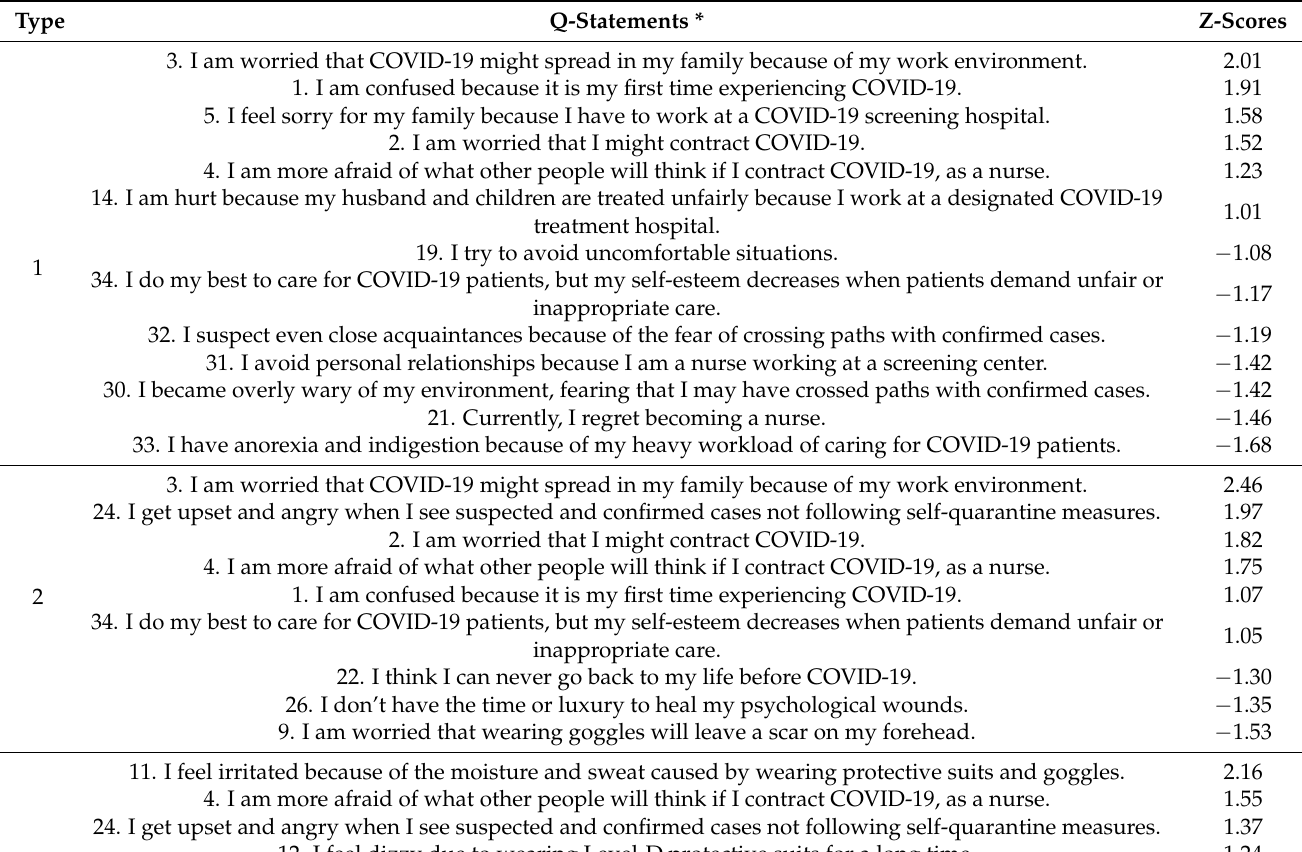
Table 4. Q-statements and array Z-scores for each type and consensus items.